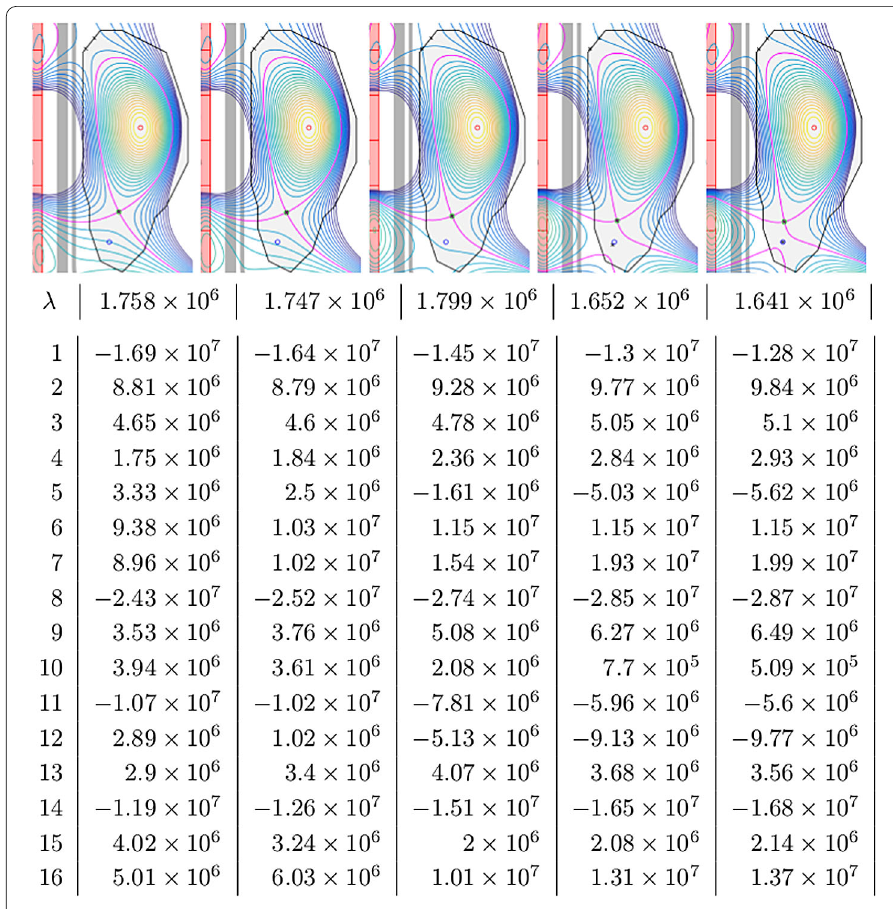
Figure 13 Results (A). The poloidal flux contour lines (top) and the 16 coil currents (bottom) in Ampère turns for the optimal control problem (16) with objective functional C ( y ; w , x 0 ) for w = 0,1,10,100,1000 (from left to right), x 0 = (5.42,–4.62) is indicated by the blue